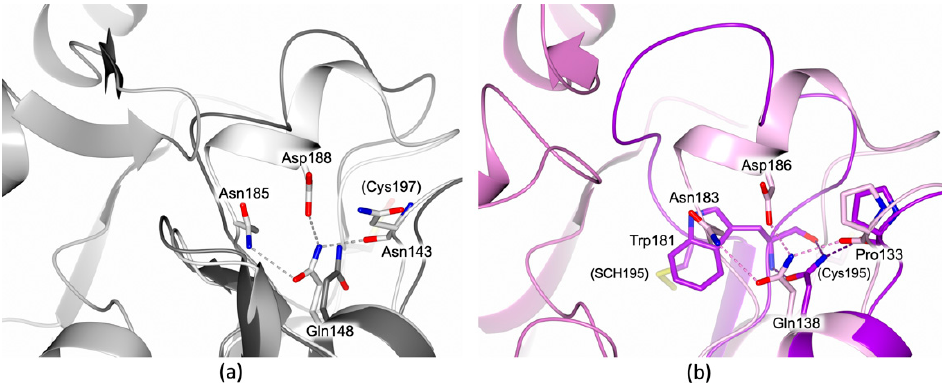
Figure 8. ( a ) Structural superimposition between the closed (white cartoon and carbon atoms; H-bonds as light grey dashed lines) and the open (dark grey cartoon and carbons) states of Ef TS. ( b ) Structural comparison of the active (pink cartoon and carbon atoms, H-bonds as pink dashed lines) and the inactive (purple cartoon and carbon atoms, H-bonds as purple dashed lines) conformations of hTS.